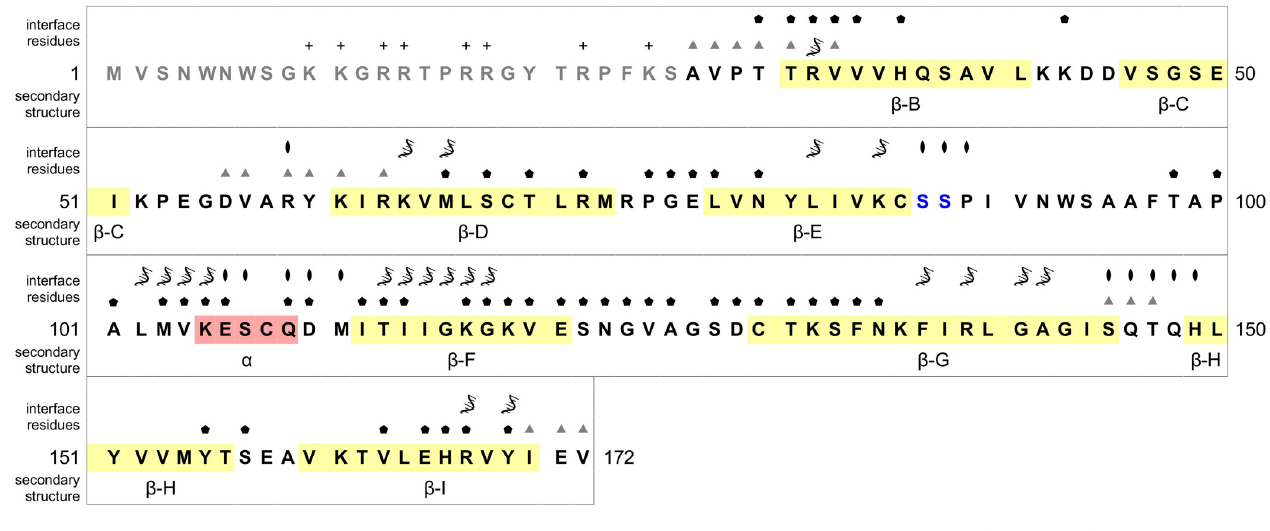
Fig 3. Full sequence of the FBNSV CP. The twenty-six N-terminal residues not visible in the 3D cryo-EM map are in grey font. Secondary structures are labelled and coloured in yellow ( β -strands) and red ( α -helix). The two serine residues targeted for site directed mutagenesis are in blue font. Residues at the CP-CP or CP-DNA interfaces are indicated by